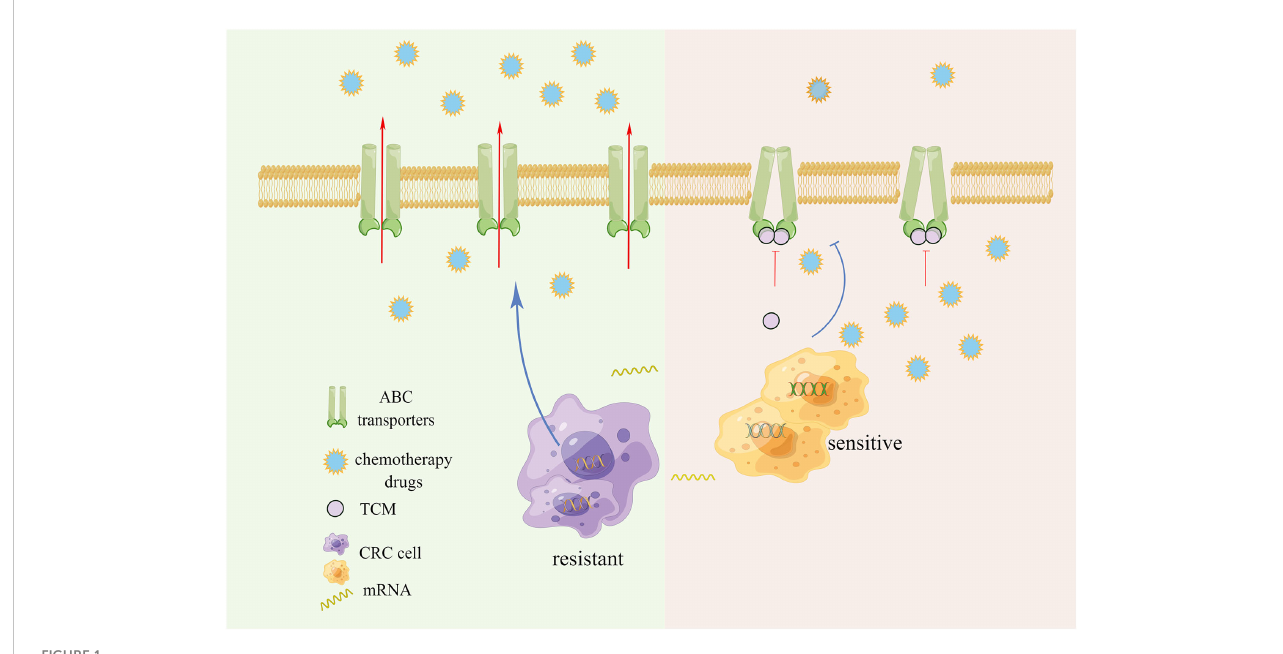
FIGURE 1 ABC transporters active drug ef fl ux and chemotherapy